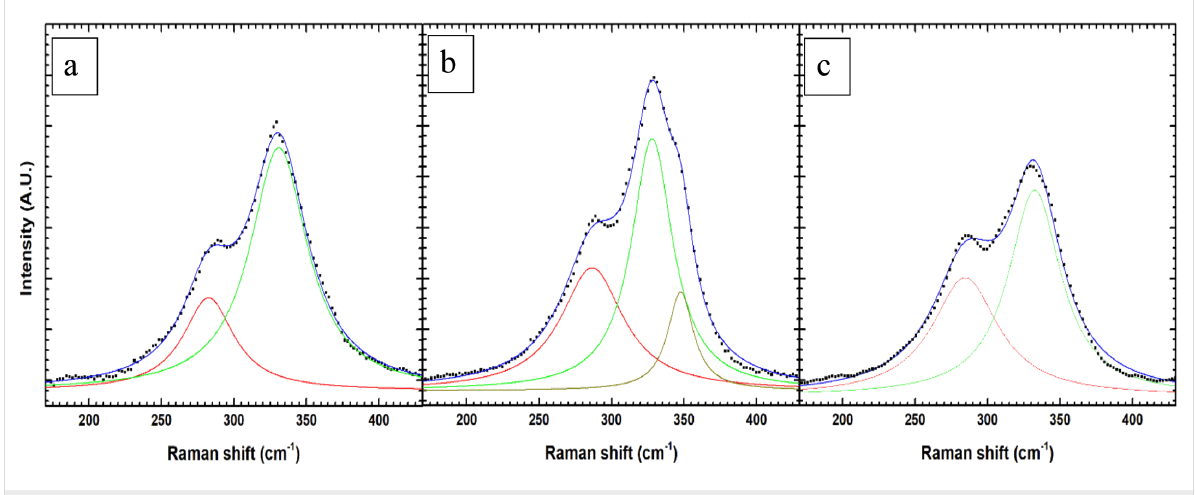
Figure 4: Raman spectra for the samples a) S1, b) S2 and c) S3.